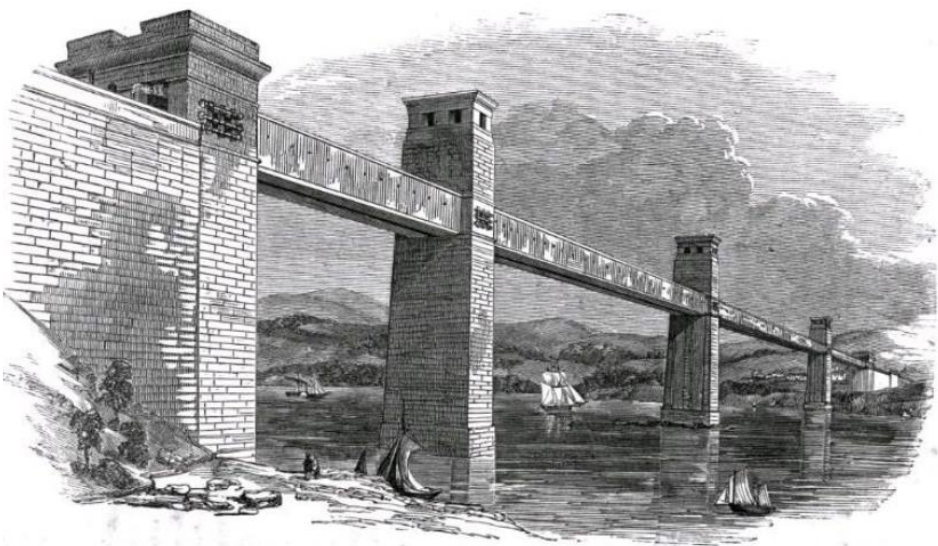
Figure 13. Britannia Bridge. General view of the “box girder” structure designed by Stephenson. Wales. 1846. Source: A cross-section of one of the tubes. Source: Dempsey 102. Engraving: “Con- struction of tubes on the Carnarvon shore.”.